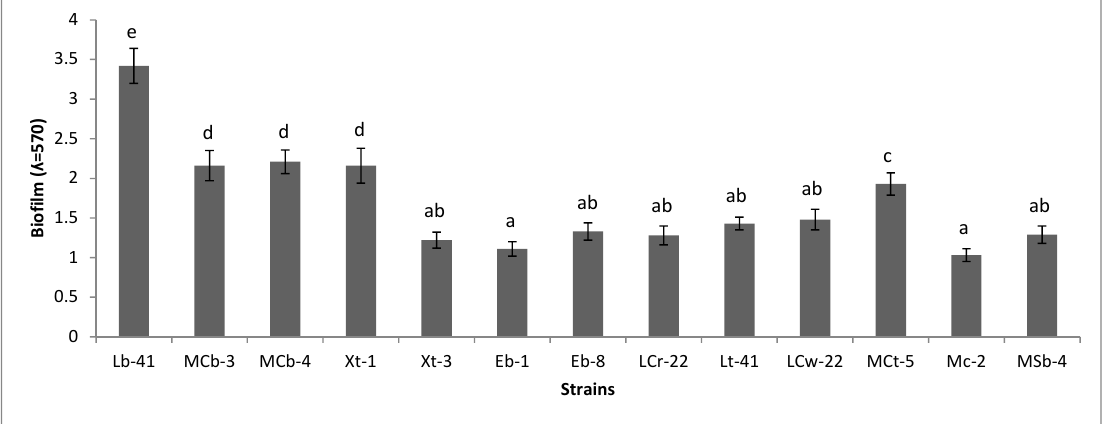
Figure 3. Auxin production by some representative purified bacterial strains in the presence and absence of L ‐ tryptophan. Strains were grown in Luria–Bertani broth (L ‐ broth) at 37 °C for 72 h. Bar represents the mean ± S.E. of three replicates. Different letters on bars indicate significant differences between respective treatments using Duncan’s multiple range test ( p ≤ 0.05).